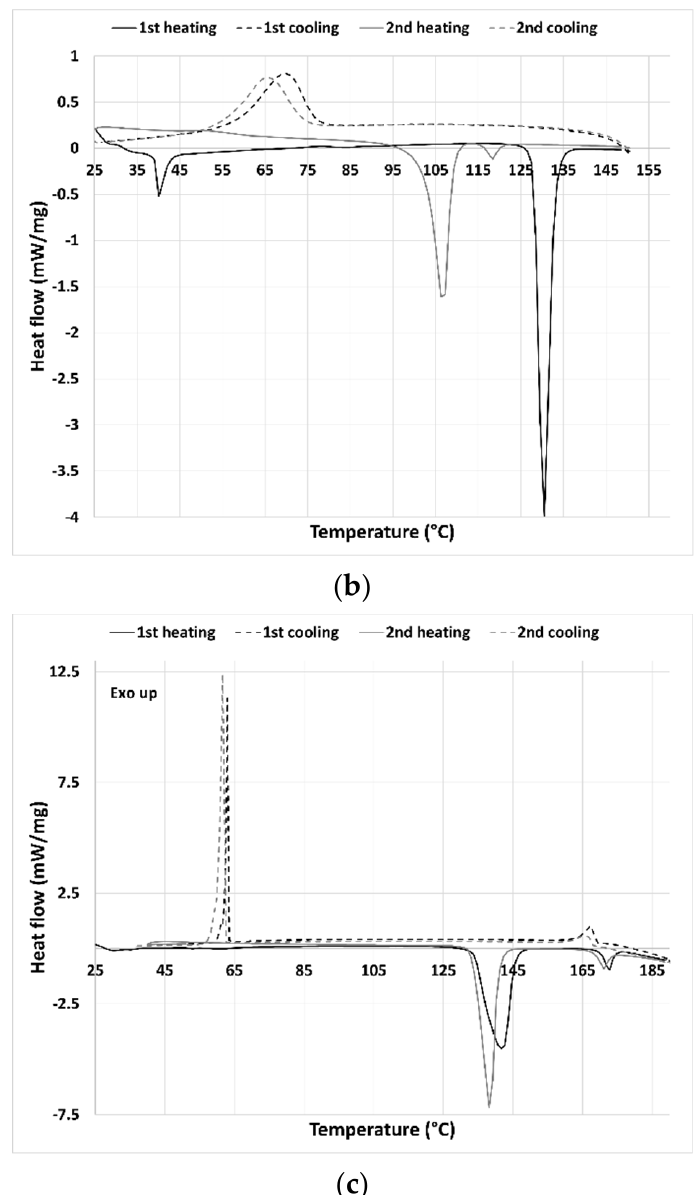
Figure 2. DSC thermograms from cooling/heating cycles from ( a ) pure CLP, ( b ) pure TLB, and ( c ) pure TRIS.